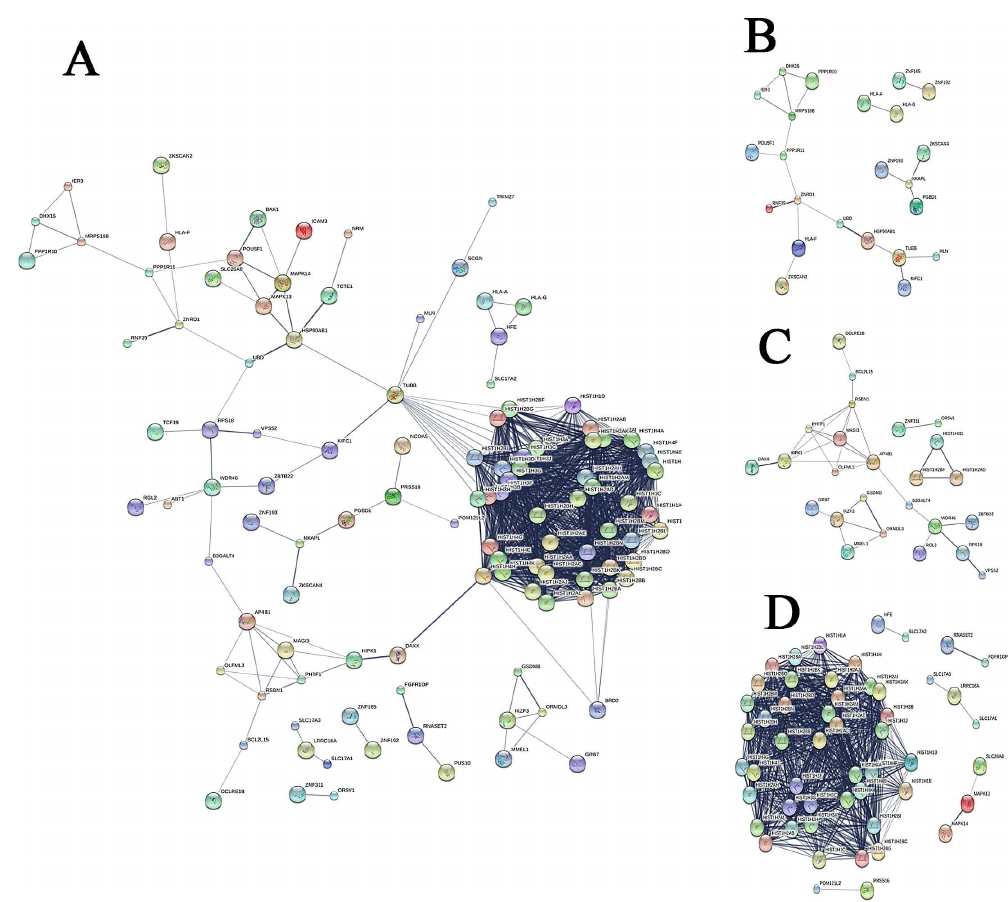
Fig 2. PPI network analysis for the 221‘novel’RA-associated genes. This is the confidenceview of protein- protein interactions producedby STRING for(A) 221 total, (B) 71 overlapped,(C) 76 European-specific and (D)74 Asian-specific gene-based RA-associated genes whose integratedscores are biggerthan 0.4. The disconnected nodesare not shown in the figure. Stronger associationsare represented by thicker lines. The most visible gene set is mainly composedby histone 1H family both in (A) and